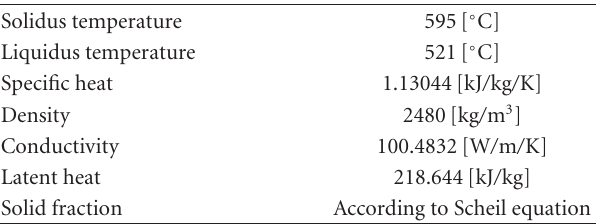
Table 1: Material properties.